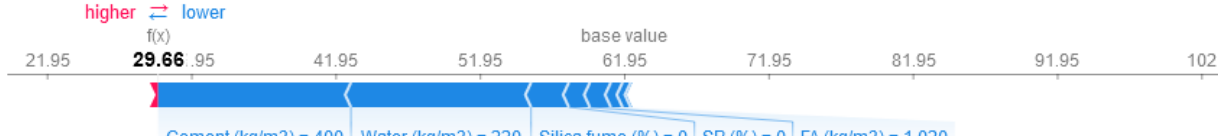
Figure 21. Compressive strength SHAP plot.